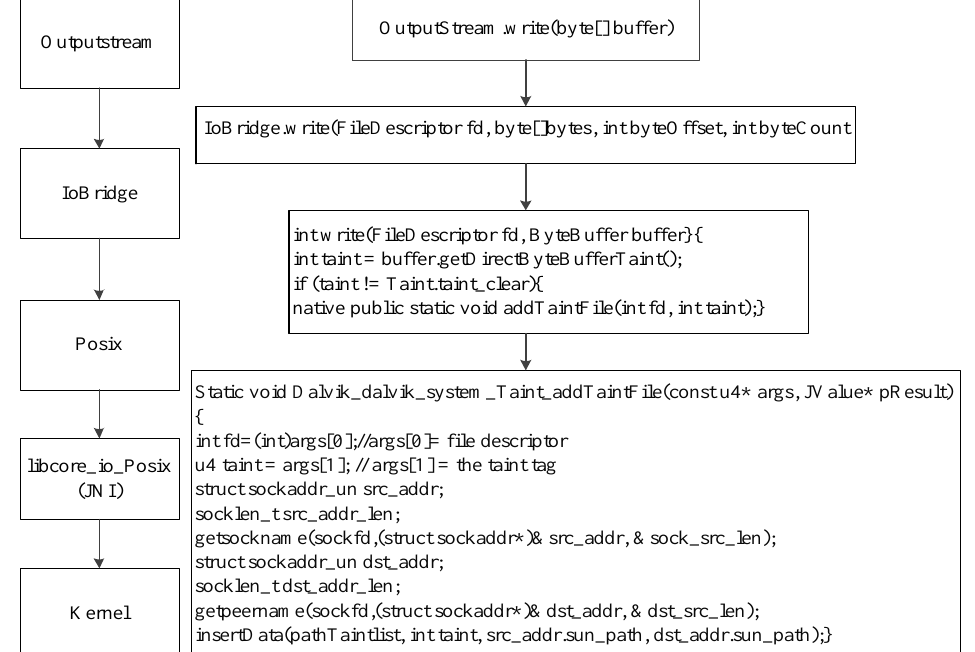
Figure 6. The “write” propagation operation.